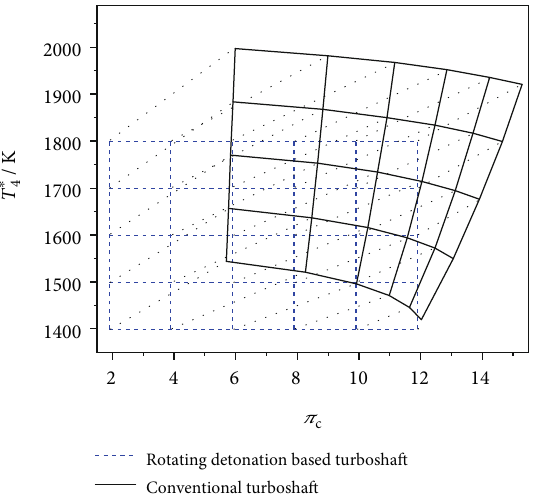
Figure 5: Cycle parameters mapping between the rotating detonation turboshaft engine and the conventional one with the same performance